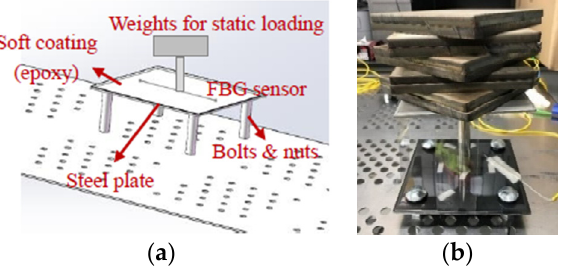
Figure 6. Test set-up of loading experiment: ( a ) schematic view and ( b ) a photo.